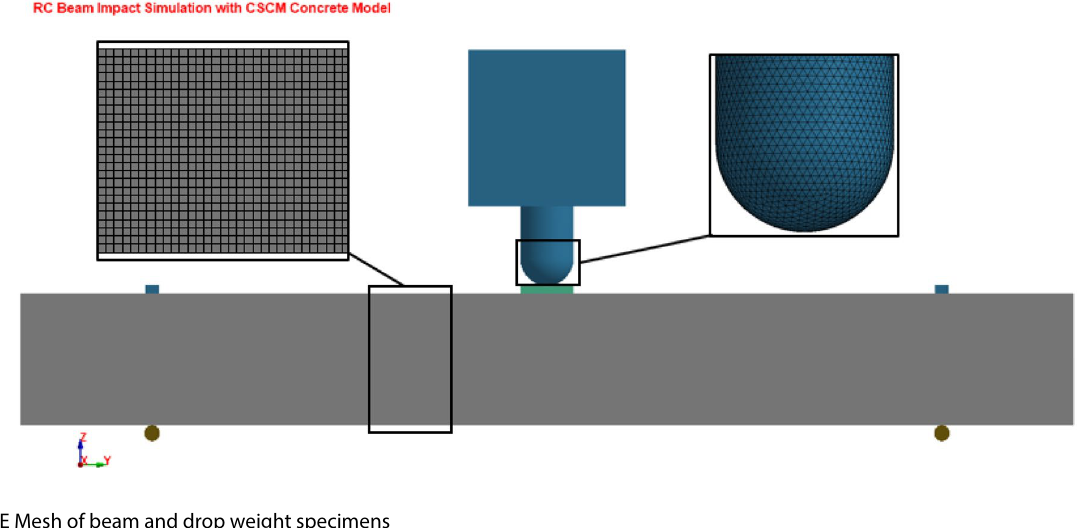
Fig. 4 FE Mesh of beam and drop weight specimens